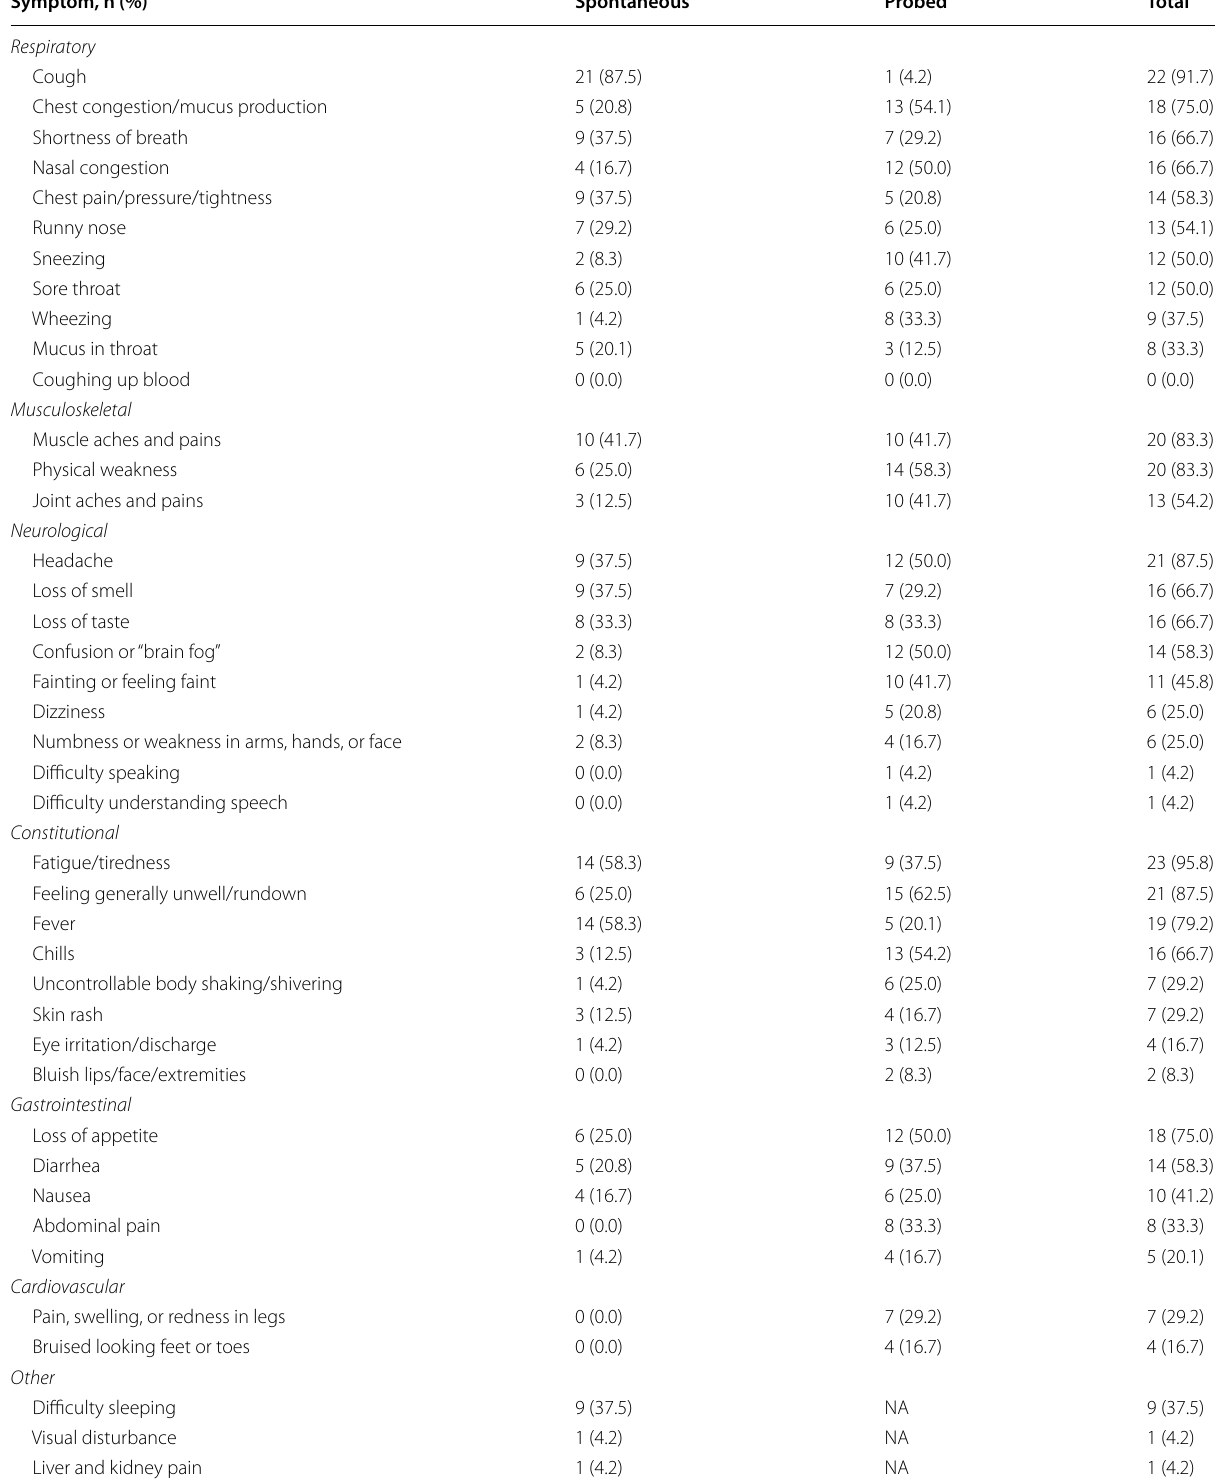
Table 3 Signs and symptoms reported by patients with COVID-19 (n